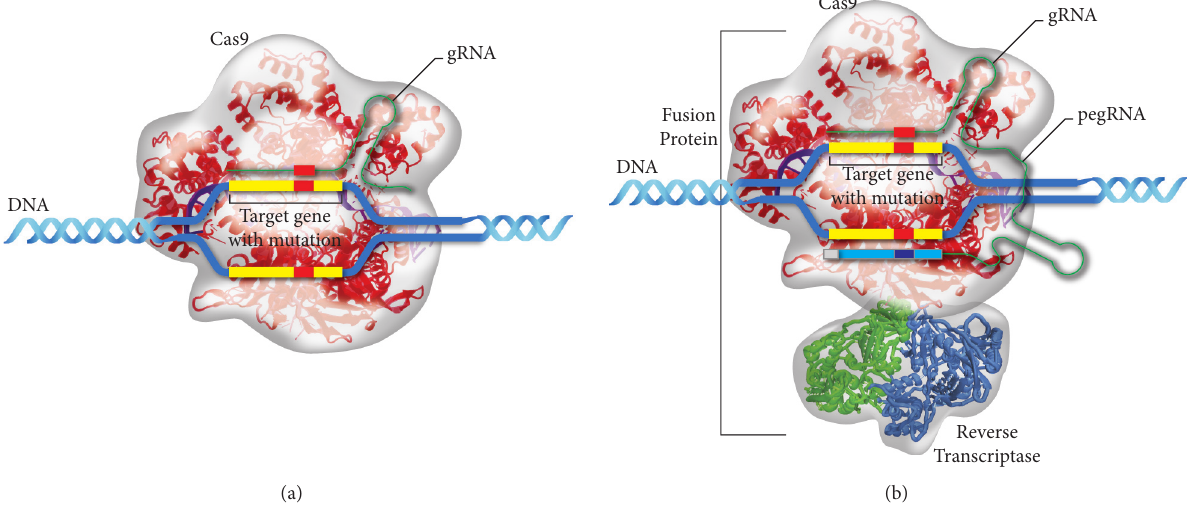
Figure 1: Two genome-editing approaches: (a) active CRISPR-Cas9 editing in dividing cells and (b) prime editing, active in dividing and nondividing